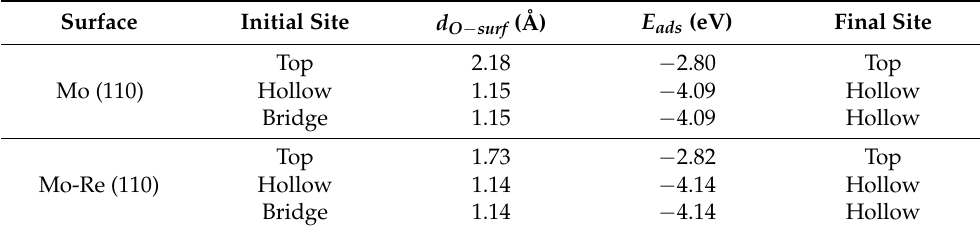
Table 3. Adsorption energy of O on Mo/Mo-Re (110)